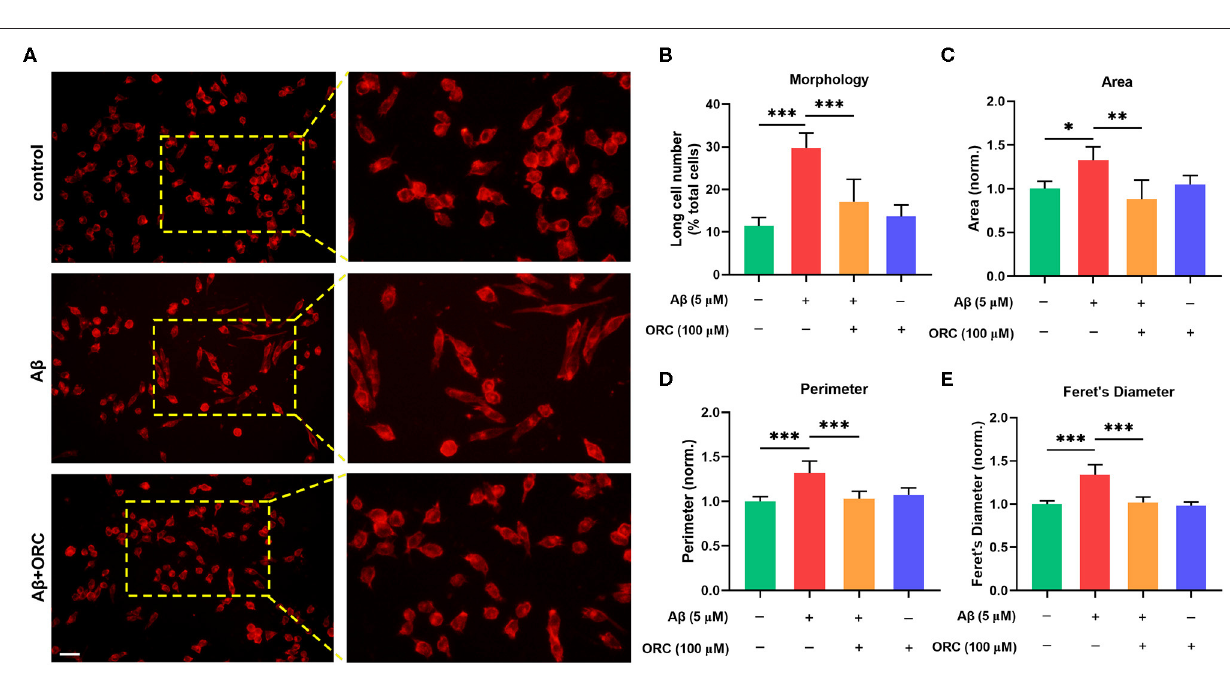
group was increased by approximately 15% (26.90 ±